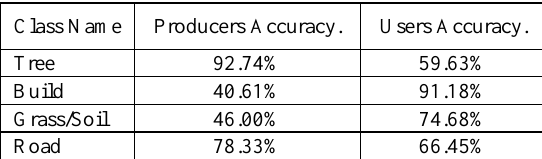
Table 2: Producer and User Accuracies of the Pixel-Based